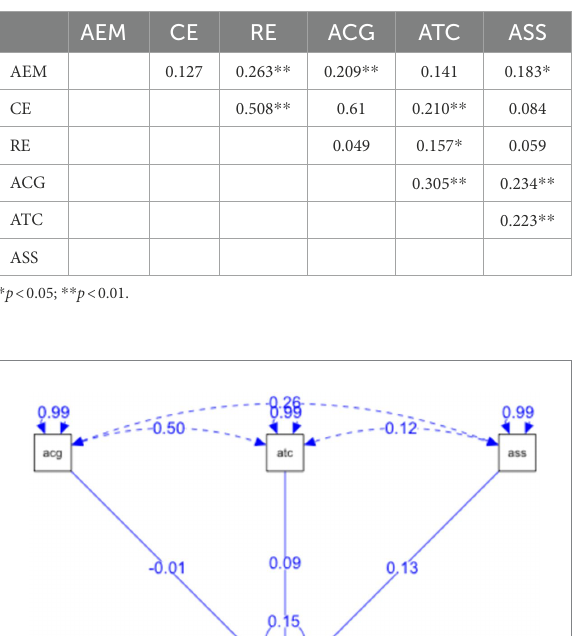
TABLE 2 Bivariate correlation analysis.